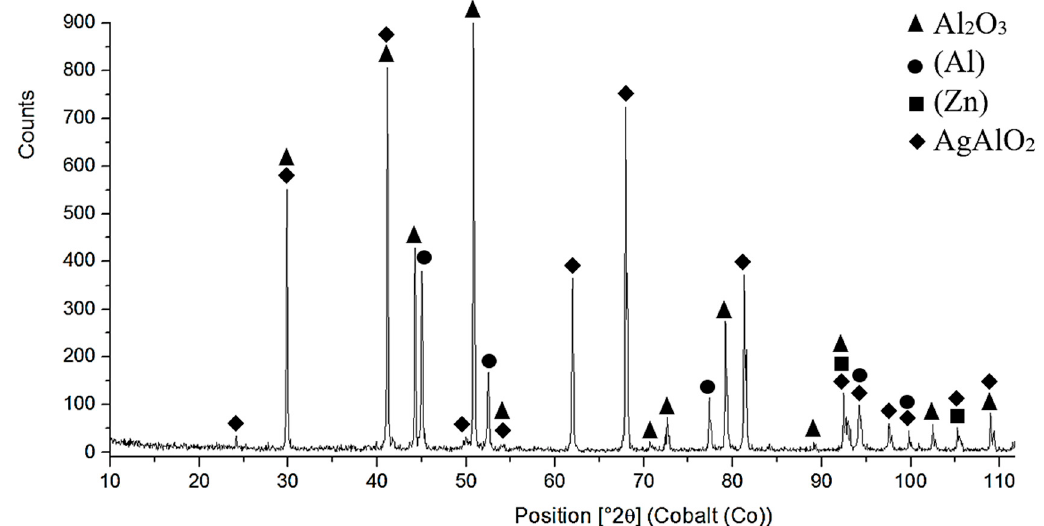
Figure 16. XRD analysis of fractured surface of Al 2 O 3 /Zn6Al6Ag joint.